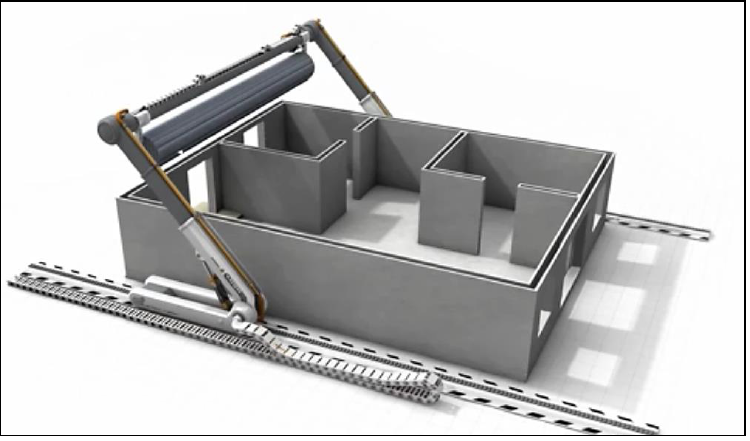
Figure 4. The ceiling installation step by CC machine